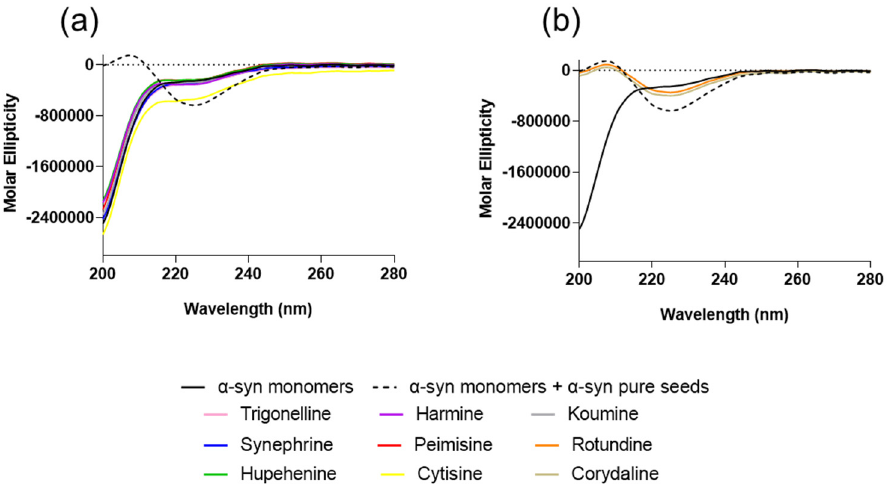
Figure 4. Circular dichroism (CD) spectra showing secondary structural changes in the presence of alkaloid compounds ( a , b ). Means ± standard deviations are from triplicates of one experiment.